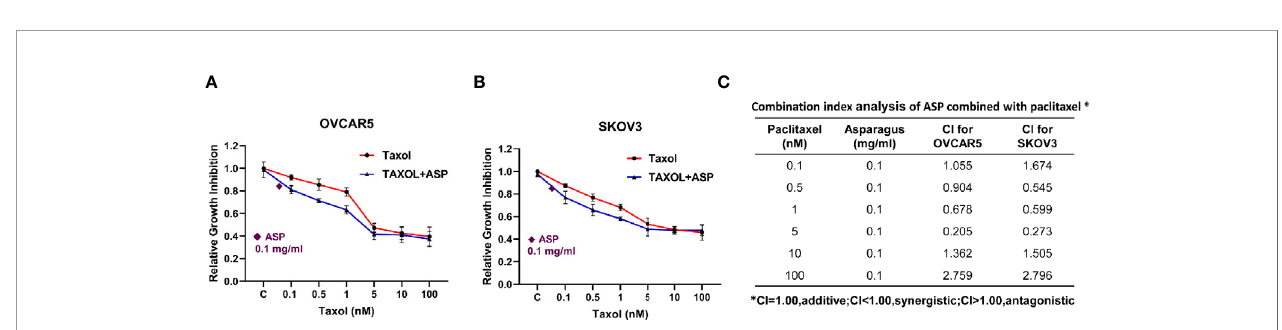
FIGURE 8 | ASP increased sensitivity to paclitaxel in OC cells. The OVCAR5 and SKOV3 ovarian cell lines were treated with 0.1 mg/ml ASP combined with different concentrations of paclitaxel for 48 hours. Cell proliferation was assessed by MTT assay. ASP combined with paclitaxel (0.1-5 nM) caused a synergistic cytotoxic effect in both cells (A, B) . The combination index (CI) was calculated using CompuSyn software (C) . *CI < 1: synergism, CI = 1: additive effect, and CI > 1: